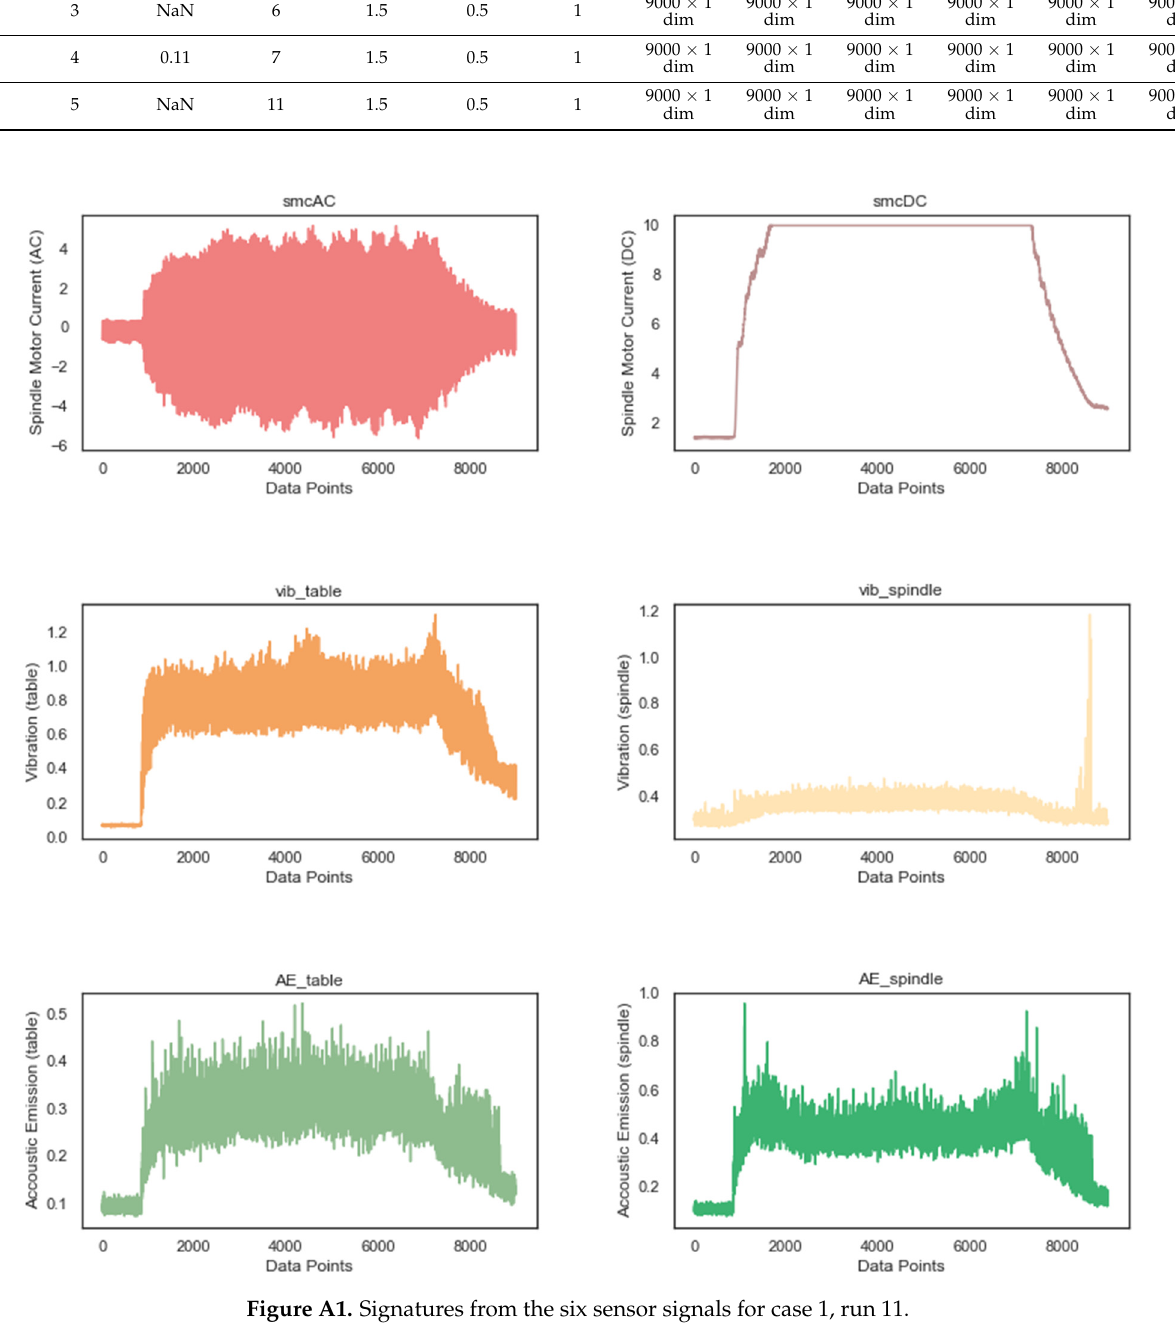
Table A1. Snapshot of the dataset.